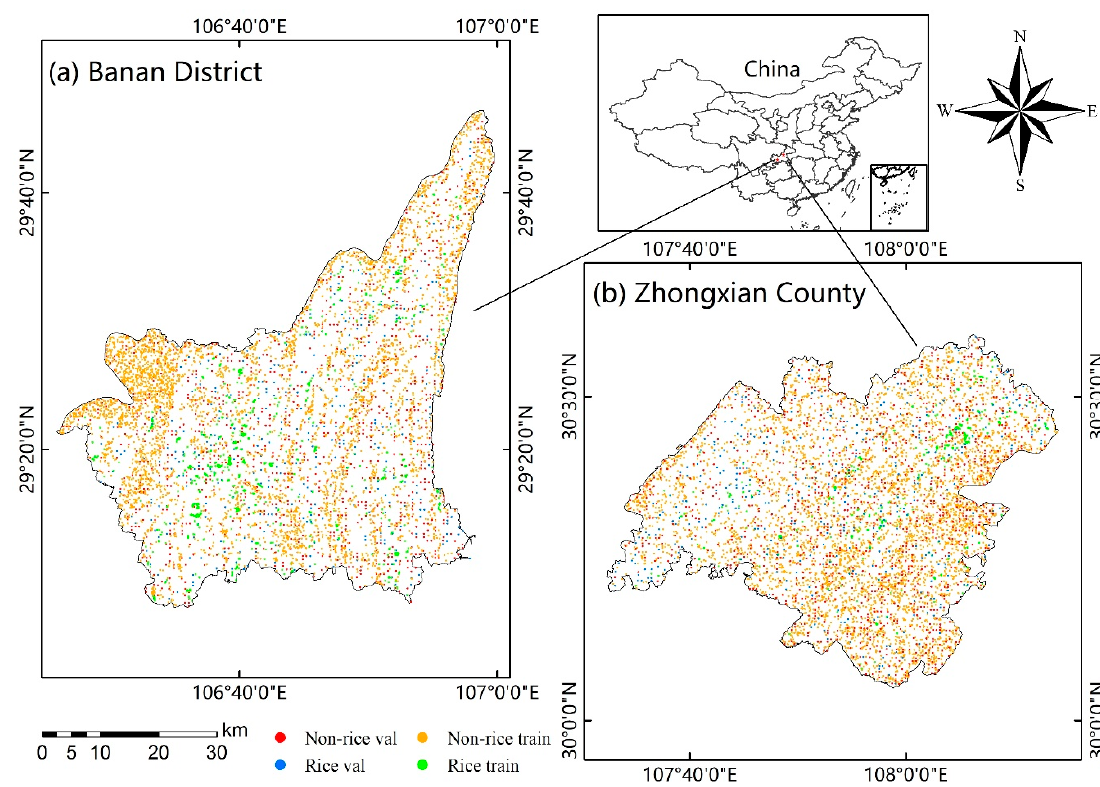
Figure 1. Maps of location, training samples and validation samples of Banan District ( a ) and Zhongxian County ( b ). “Non-rice val “and “Rice val” represent validation samples and “Non-rice train” and “Rice train” denote training samples (more detailed information please refer to supplementary (i.e., Figures S3 and S4)).